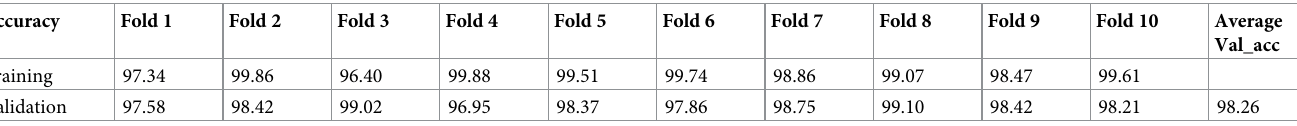
Table 21. Performance of proposed model on the dataset after augmentation with various splitting ratios. Split ratio Optimizer Learning Rate (Training:validation:test) 60:30:10